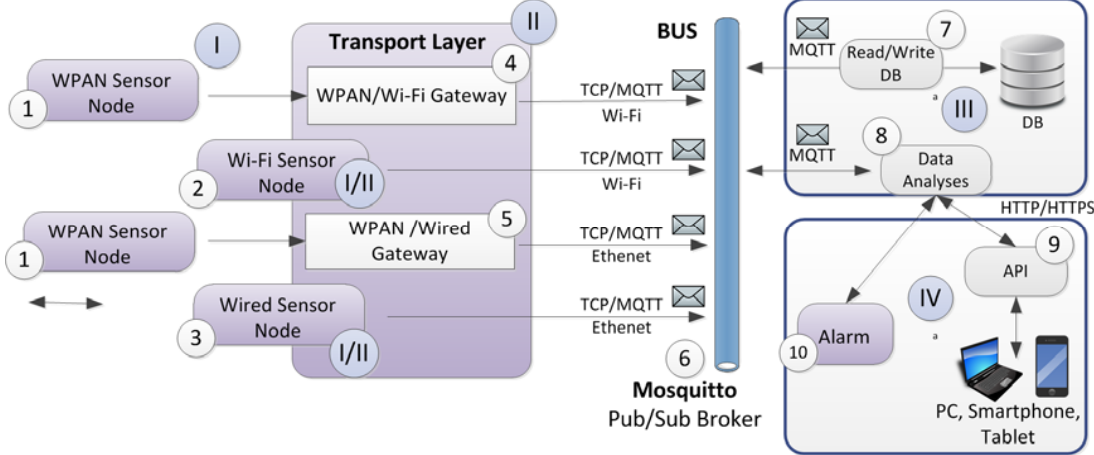
Figure 2. The architecture of the software components of the system.